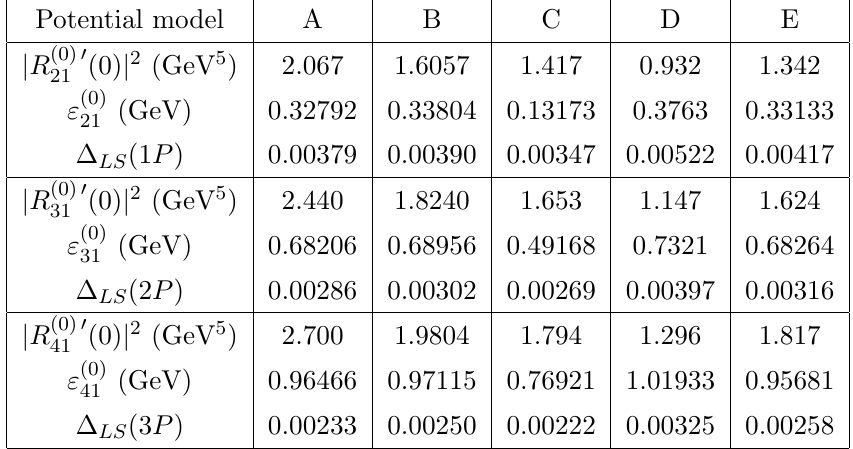
Table 2 . Similar to table 1 but for bottomonium nP states. In the bottomonium case, we also consider the model E described in the